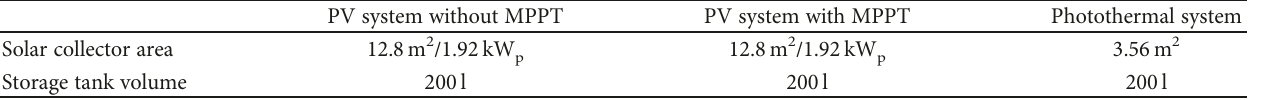
Table 5: Main parameters of experimental solar water heating systems.